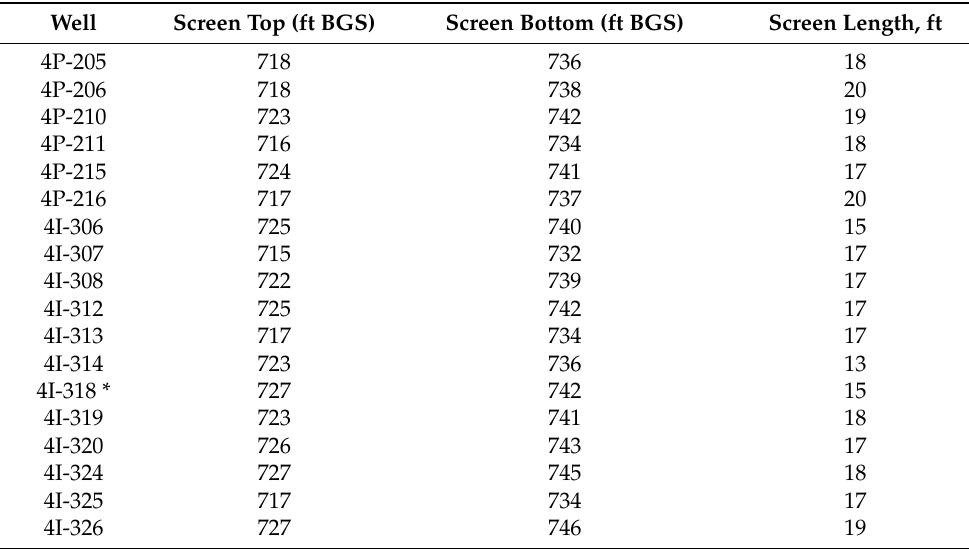
Table A1. Completion intervals and depths of screened intervals in wells used in the HH 4-11 amendments test (see Figure 2 for well layout). BGS = Below ground